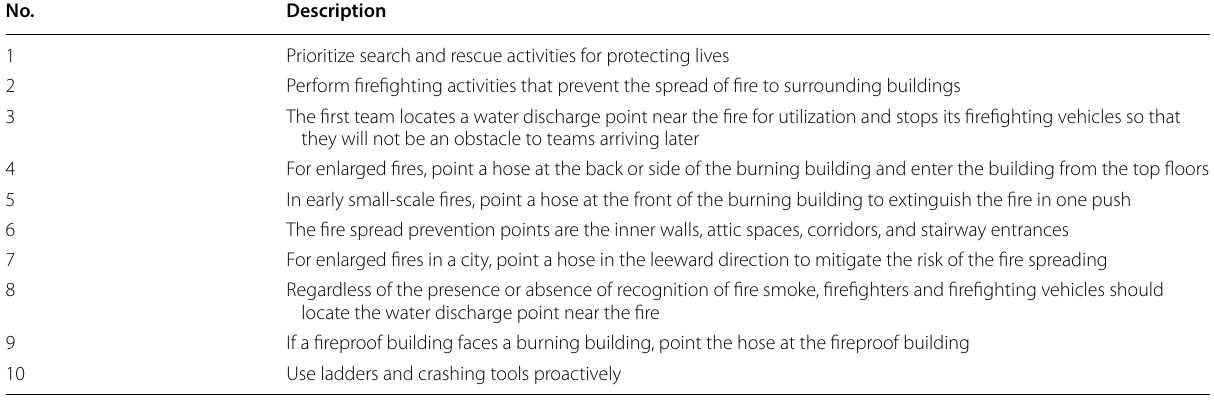
Table 1 Ten principles for basic firefighting tactics No.